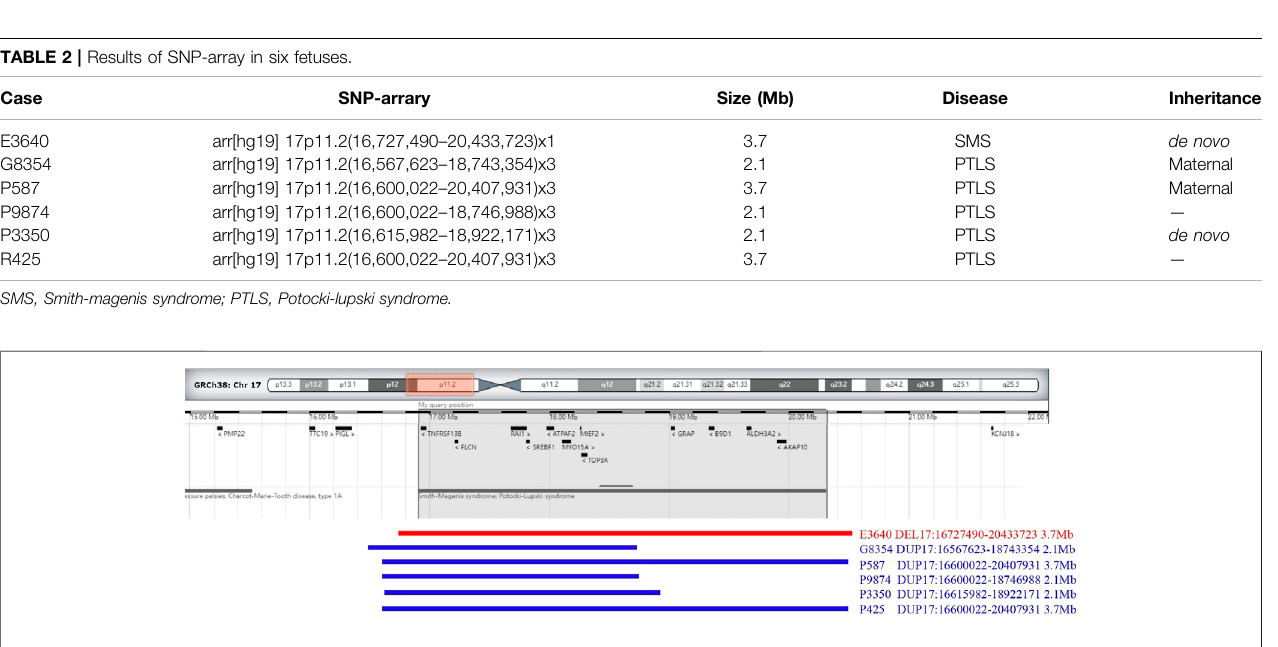
FGR, fetal growth restriction; VSD, ventricular septal defect. The fetuses G8354 and P587 were from the same mother, and the mother displayed intellectual disability.